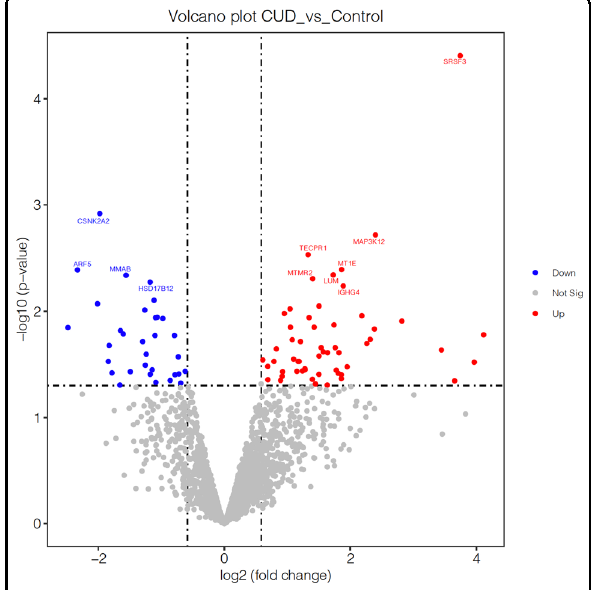
Fig. 5 Differentially expressed proteins in patients with CUD and HCs. Volcano plot shows the differentially expressed proteins in patients with CUD and HCs. CUD cocaine use disorder, HC healthy